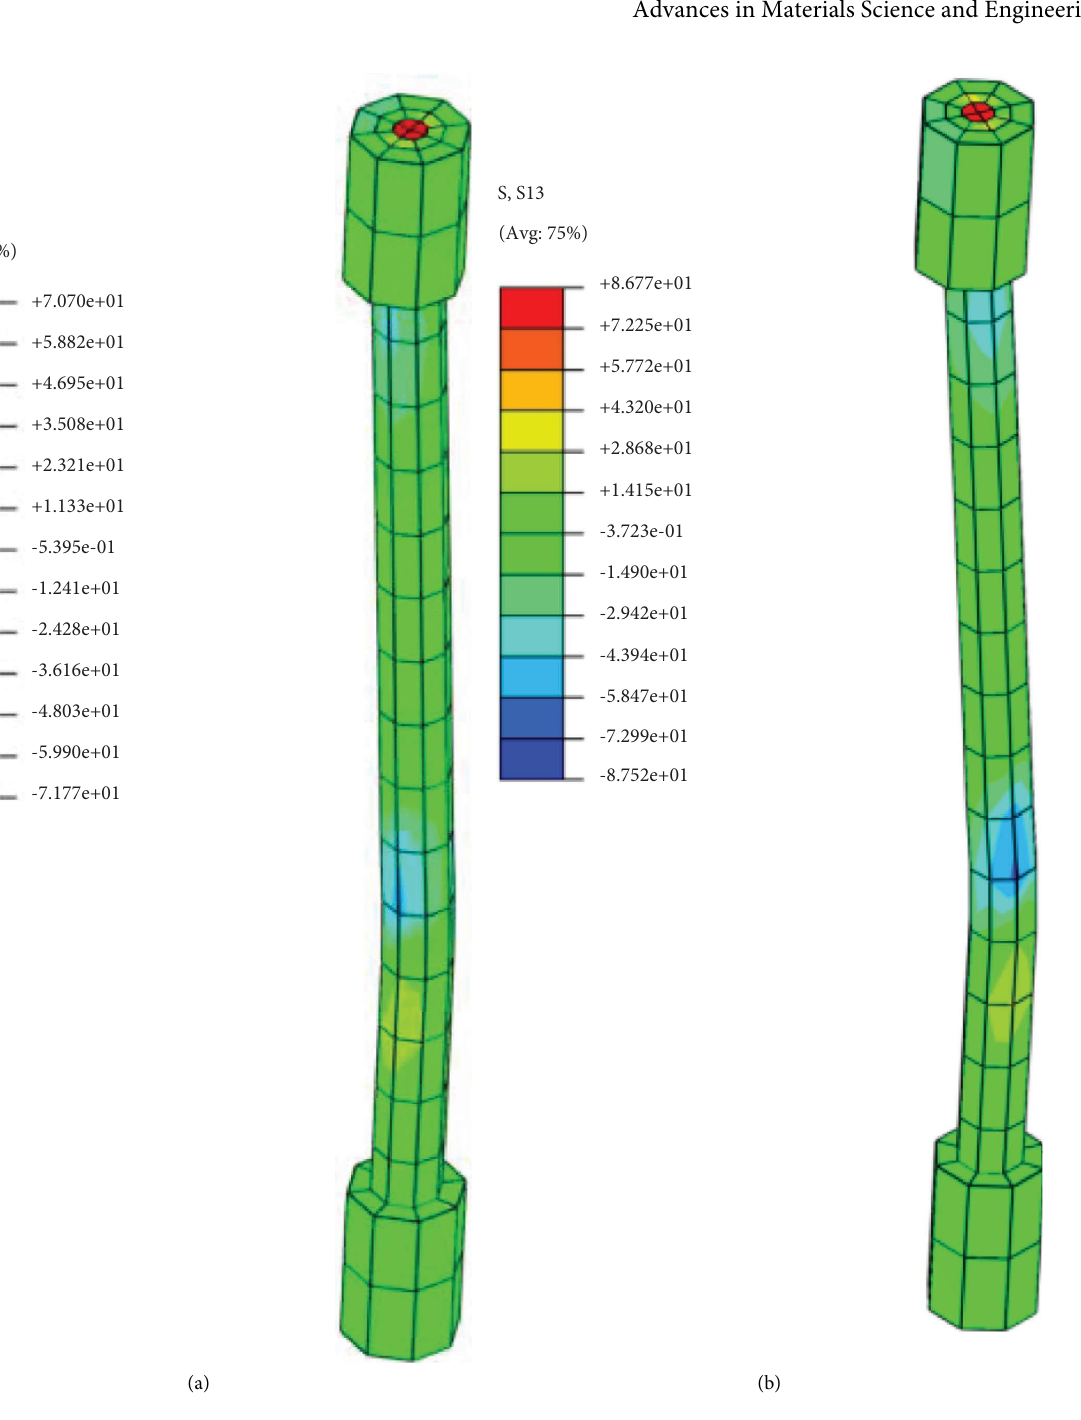
Figure 14: Simulated horizontal shear stress of connectors. (a) G24-I and (b)